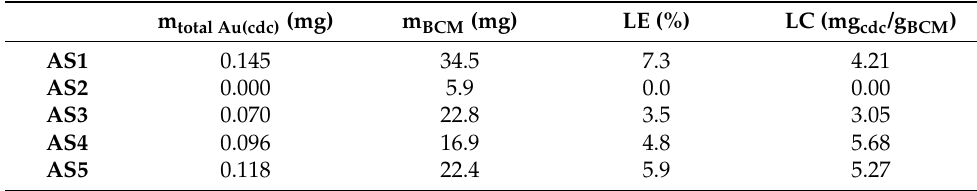
Table 2. Loading contents (LCs) and loading efficiencies (LEs) of the resulting BCMs-[Au(cdc) 2 ] (formulations AS1–AS5).